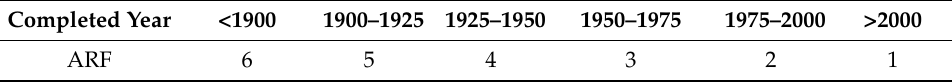
Table 2. Definition of dam age rating factors (from